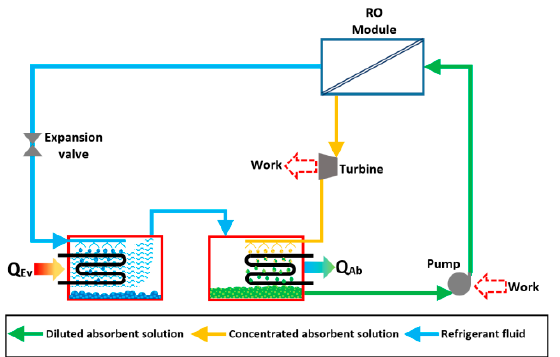
Figure 6. Schematic diagram of the cycle proposed by Su and Ri ff at